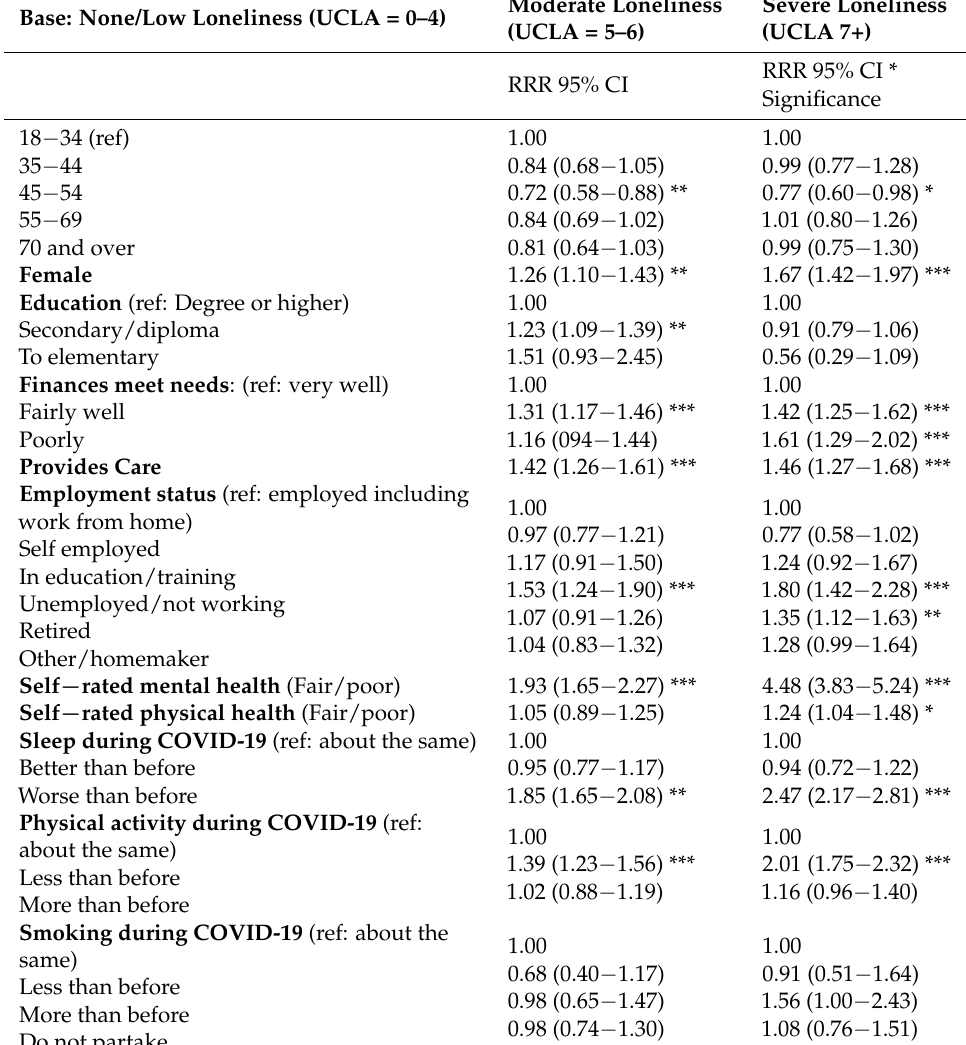
Table 3. Final multinomial logistic regression model for moderate and severe loneliness during COVID-19